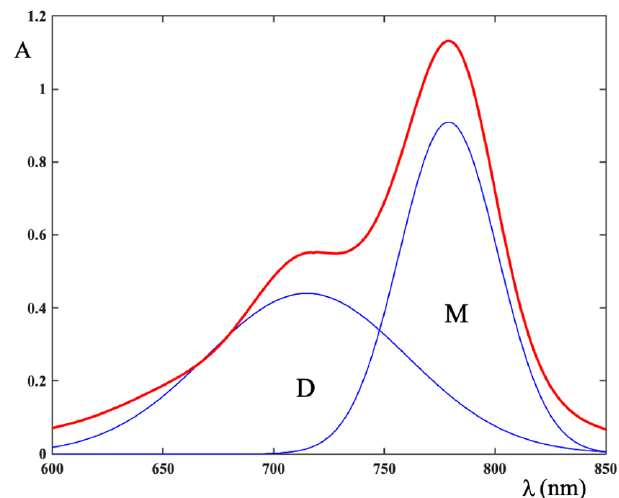
Figure 5. Monomer and dimer concentration calculated by the deconvolution of absorption spectra with two Gaussian peaks.